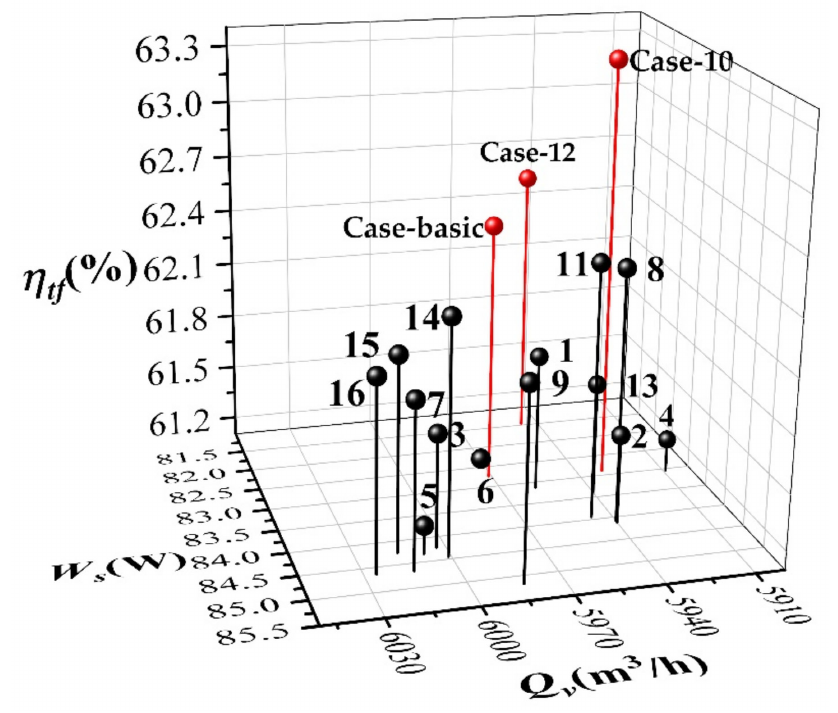
Figure 7. Calculation results of different